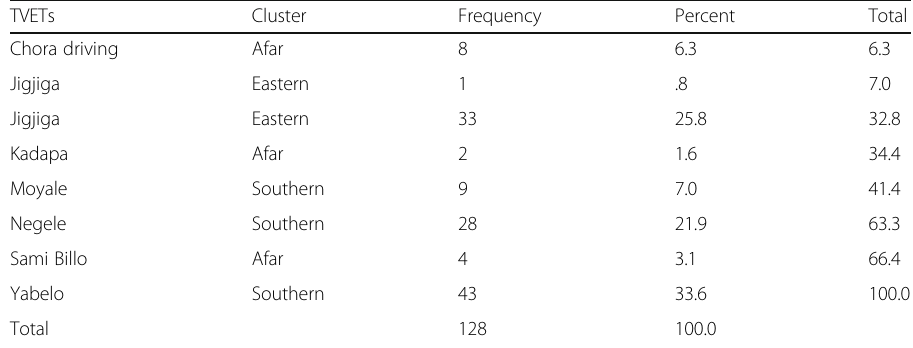
Table 4 TVET hosting short-term training graduates from 2014 to 2017 TVETs Cluster Frequency Chora driving Afar